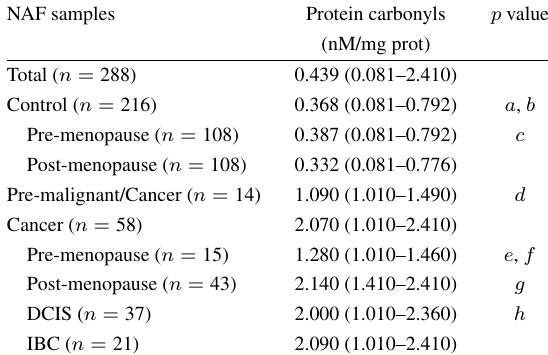
Median of protein carbonyl levels in human nipple aspirate fluid samples NAF samples Protein carbonyls